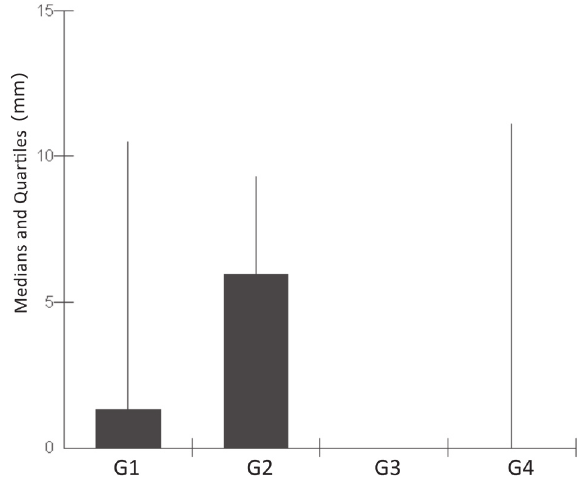
Figure 4- Medians and quartiles (25% and 75%) according to the experimental Table 1- Relative Risk found in the groups confronts